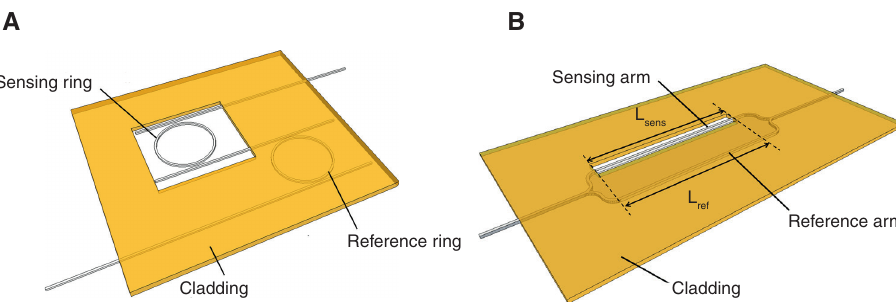
Figure 1: Schematic of both sensor types. In fabricated devices, waveguides can be curled into a spiral to limit the footprint, as shown in Figure 9. (A) Vernier-cascade (B) Mach-Zehnder